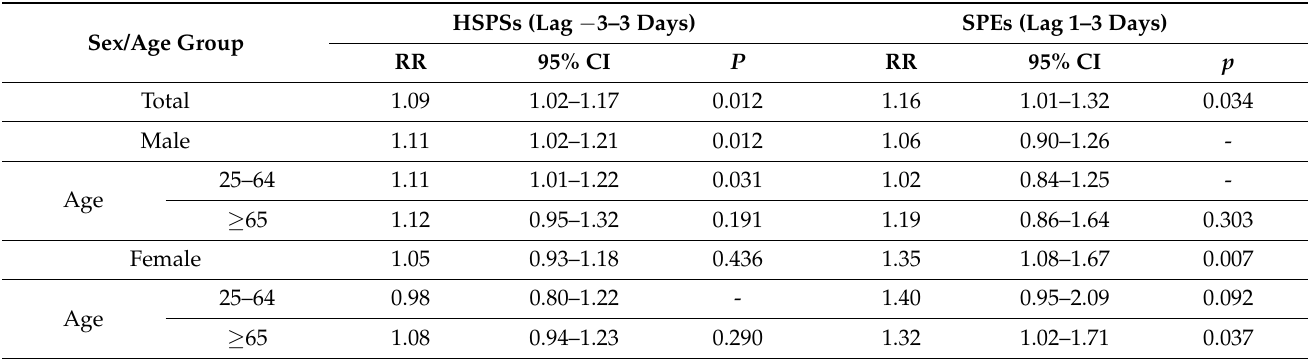
Table 9. The effects of HSPSs (lag − 3 to 3 days) and SPEs (lag 1–3 days) on the risk of death from IHD during the whole period by sex and age group.